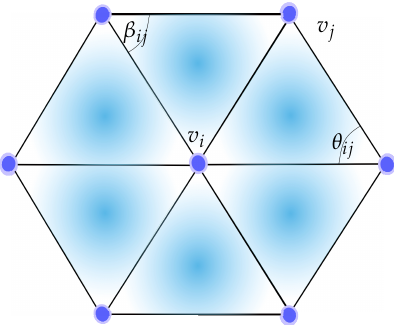
Figure 24. The angles θ ij and β ij are defined with respect to an edge [ v i , v j ] .